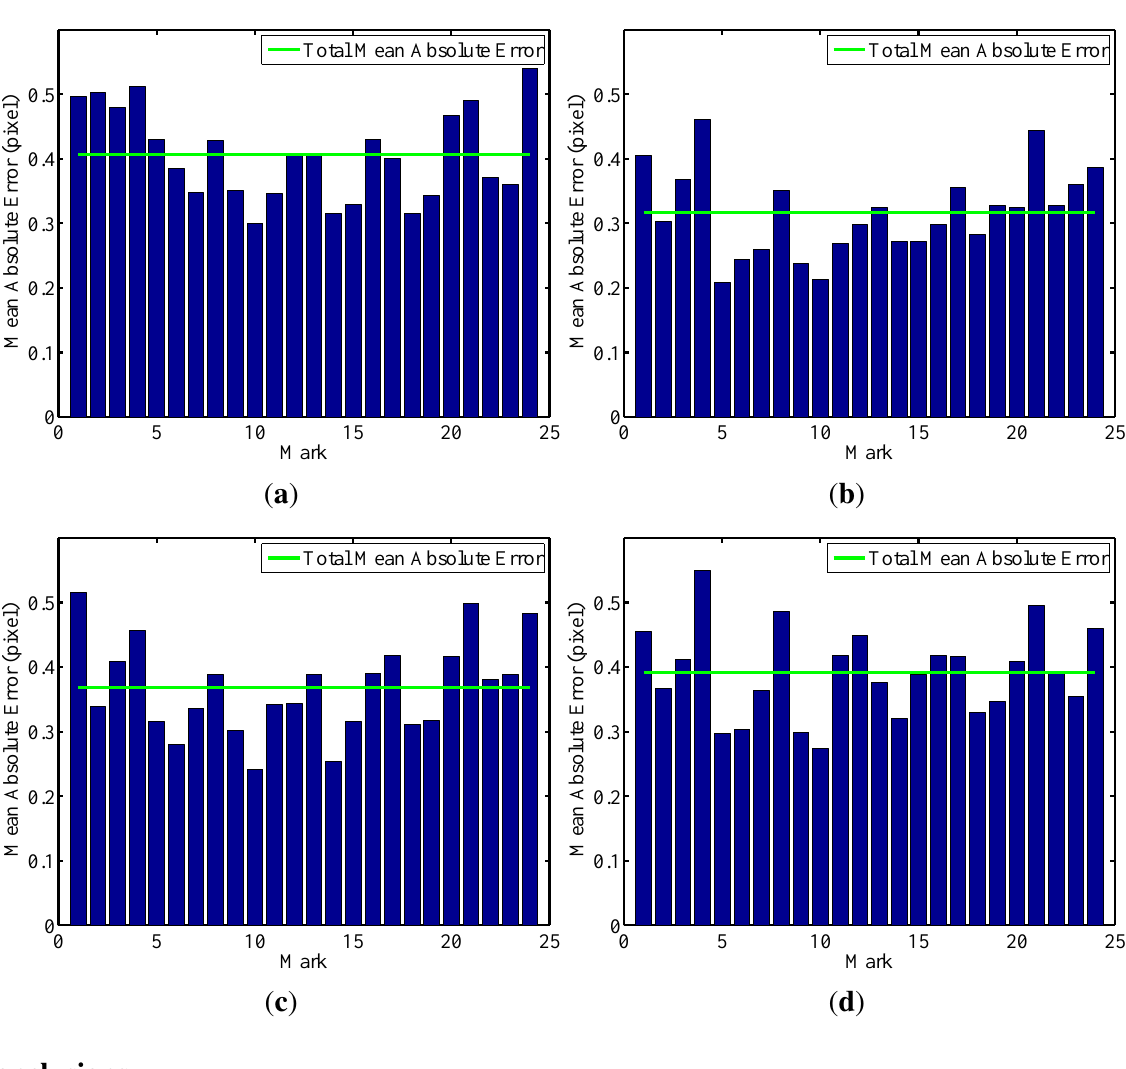
Figure 18. Reprojection error for the eight-shaped pathway. ( a ) Camera 1; ( b ) Camera 2; ( c ) Camera 3; ( d ) Camera